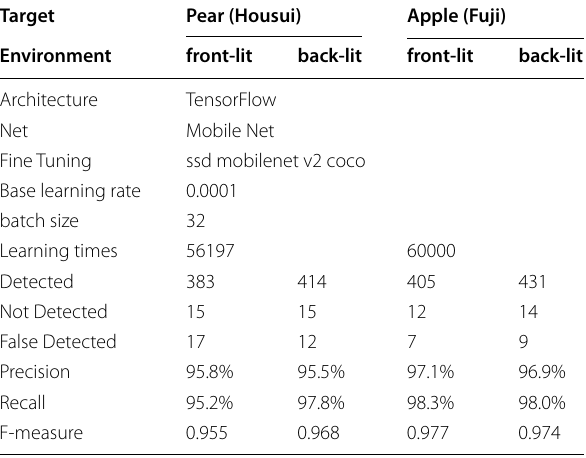
Fig. 9 Result of apple